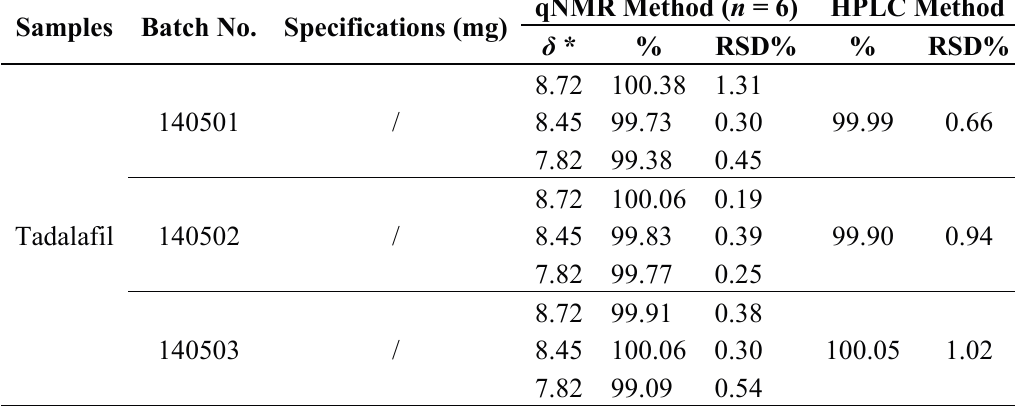
Table 4. Determination and statistical results of the qNMR and HPLC